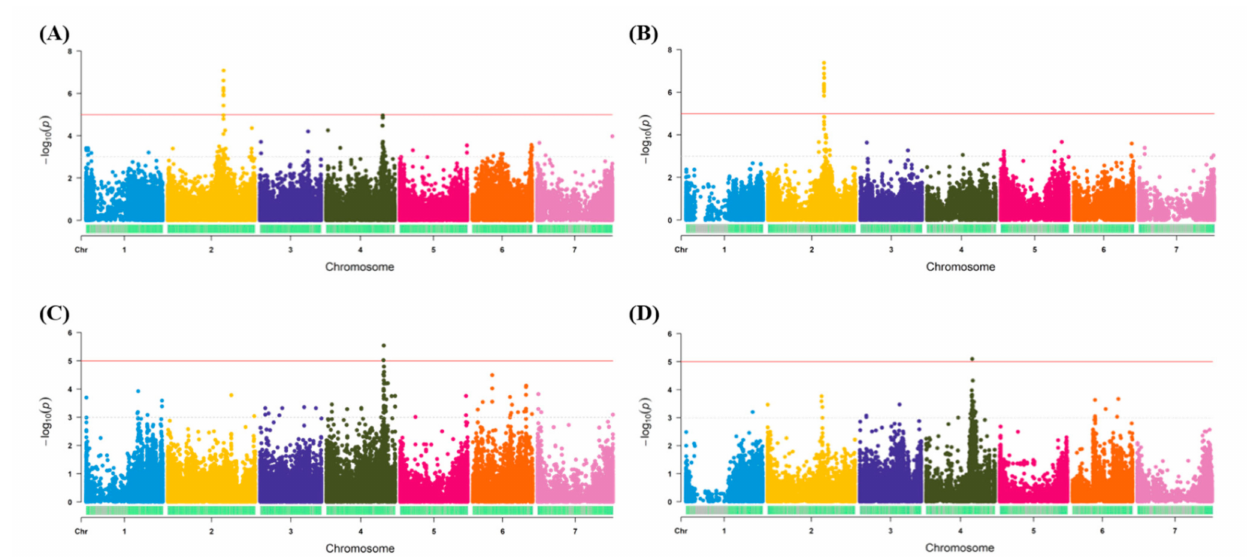
Figure 2. Marker-trait association results for salt tolerance traits. ( A ) and ( B ) represent the plots generated for traditional phenotypic scores. ( C ) and ( D ) represent the plots generated for phenomics screen green color pixels. Plots A and C were generated from the data obtained from tGBS method, while B and D were from GBS-t method. The red line indicated the significant threshold